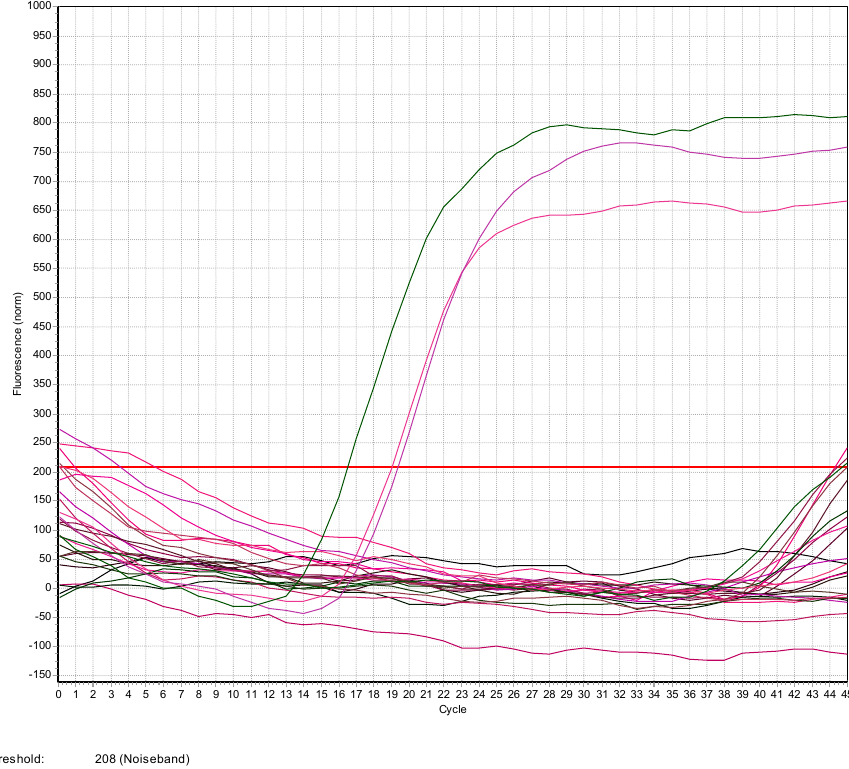
Figure 4. Real time (quantitative) PCR (qPCR) analysis for compound 1. Amplification curves for blood and tissues of five mice. Horizontal line represents threshold for amplification. All values >40 Ct and amplification curves below threshold indicate absence of target DNA. The three amplification curves above threshold correspond to positive controls.